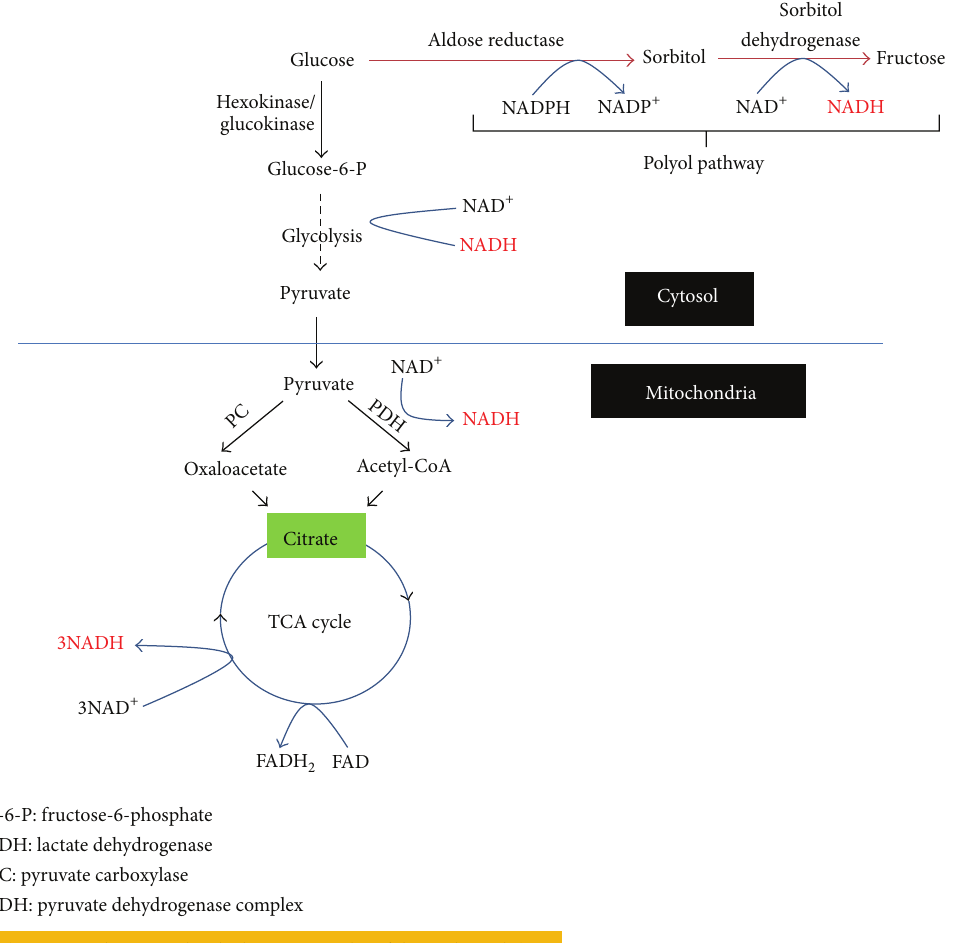
Figure 5: Pathways of NADH production during glucose combustion. These are the glycolytic pathway, the pyruvate dehydrogenase complex, and the TCA cycle. Under diabetic conditions, the polyol pathway also becomes a significant pathway for NADH production that can further perturb the redox balance between NADH and NAD +